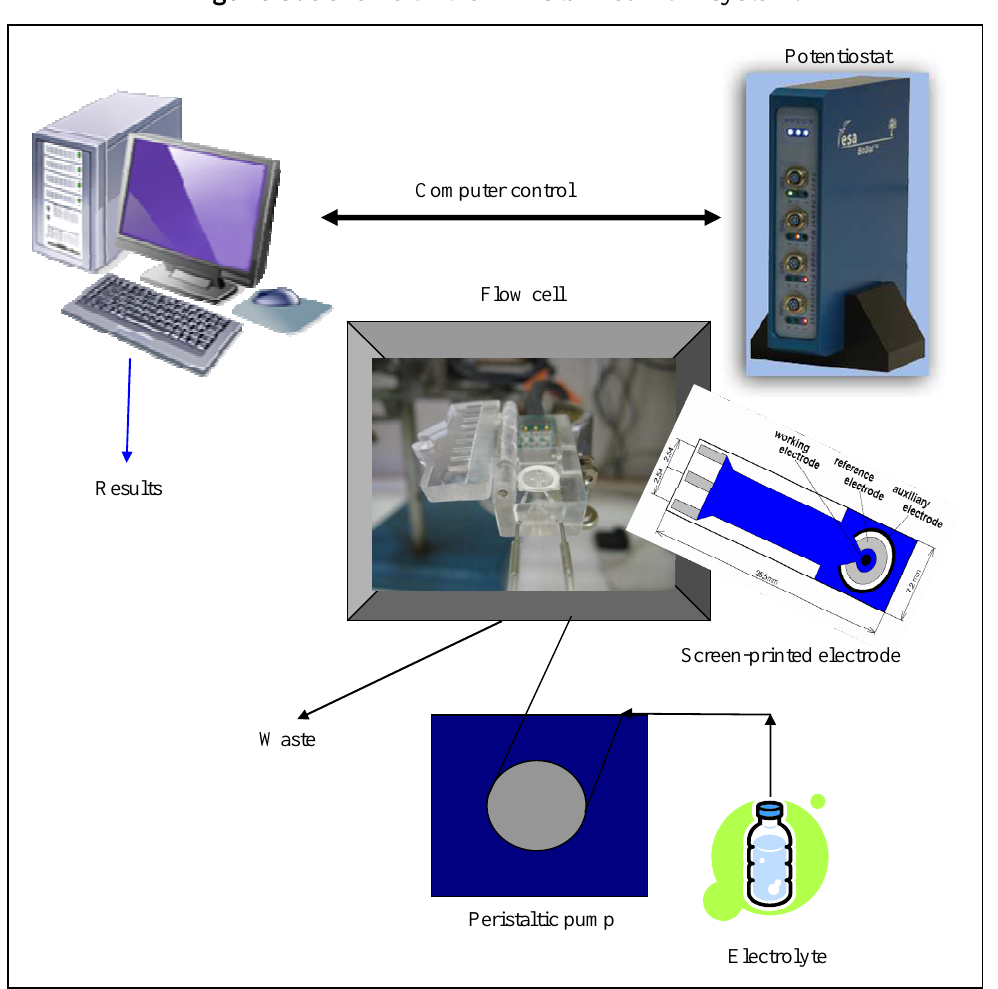
Figure 5. Scheme of the miniaturized flow